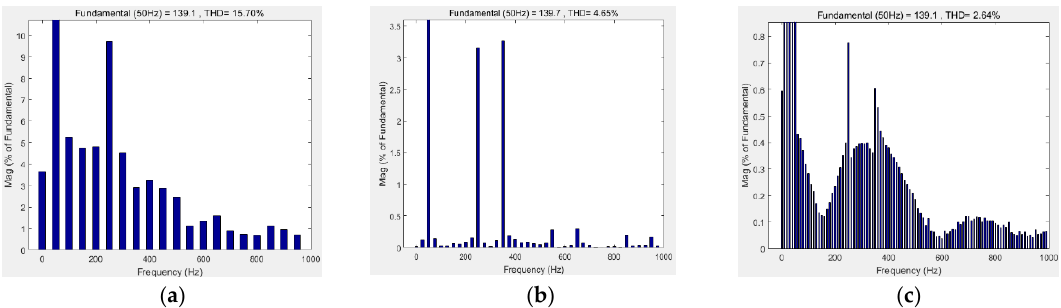
Figure 12. The utility grid current waveform spectrum. ( a ) Load current waveform spectrum uncompensated. ( b ) Grid current waveform spectrum compensated based on standard PSO algorithm. ( c ) Grid current waveform spectrum compensated based on CPSO-MAS algorithm.